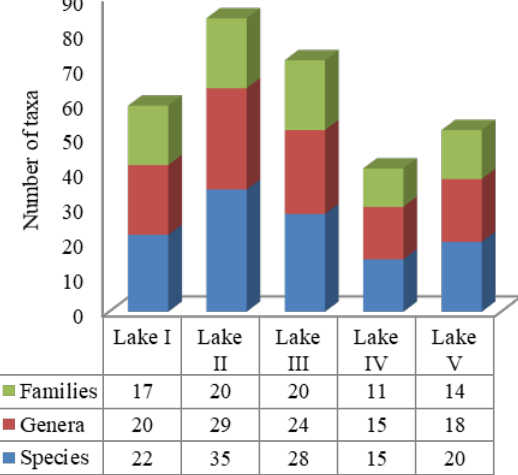
Figure 4. Sitewise distribution of taxa Lake I, II and III are seasonal i.e. they carry water for 8 - 9 months of a year, while Lake IV and V store water throughout year (Table 1). Hence, grazing by domestic cows and buffaloes are observed around Lake I, II